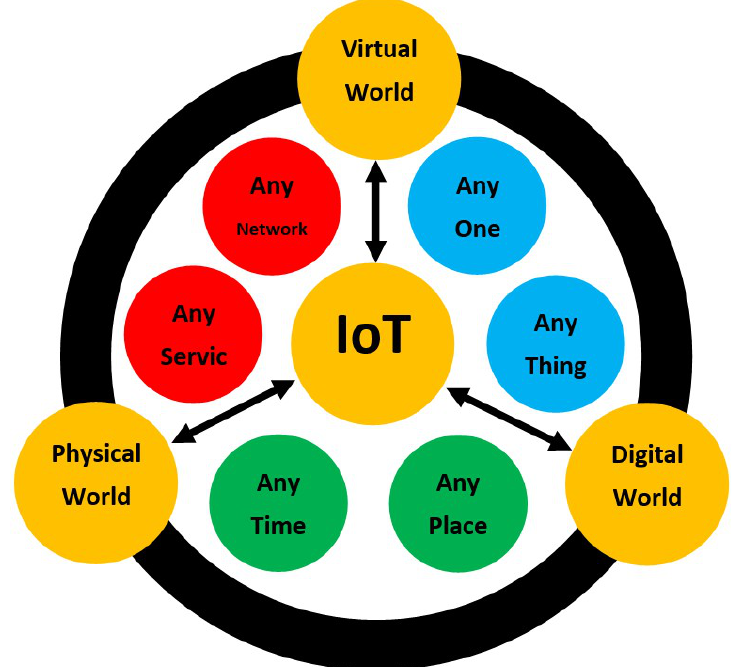
Figure 1. Internet of Things (IoT) with its connections and related entities